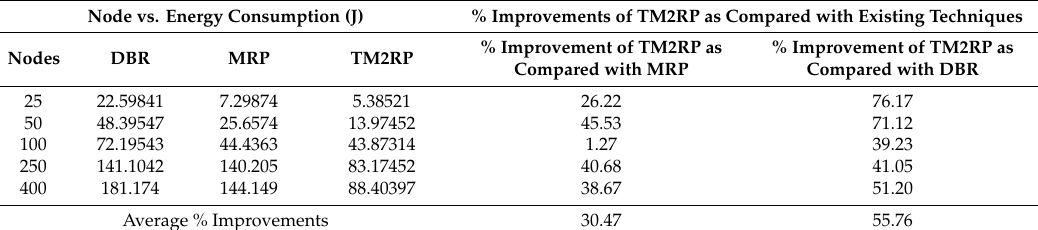
Table 2. The obtained results of TM2RP with regard to energy consumption. Node vs. Energy Consumption (J)